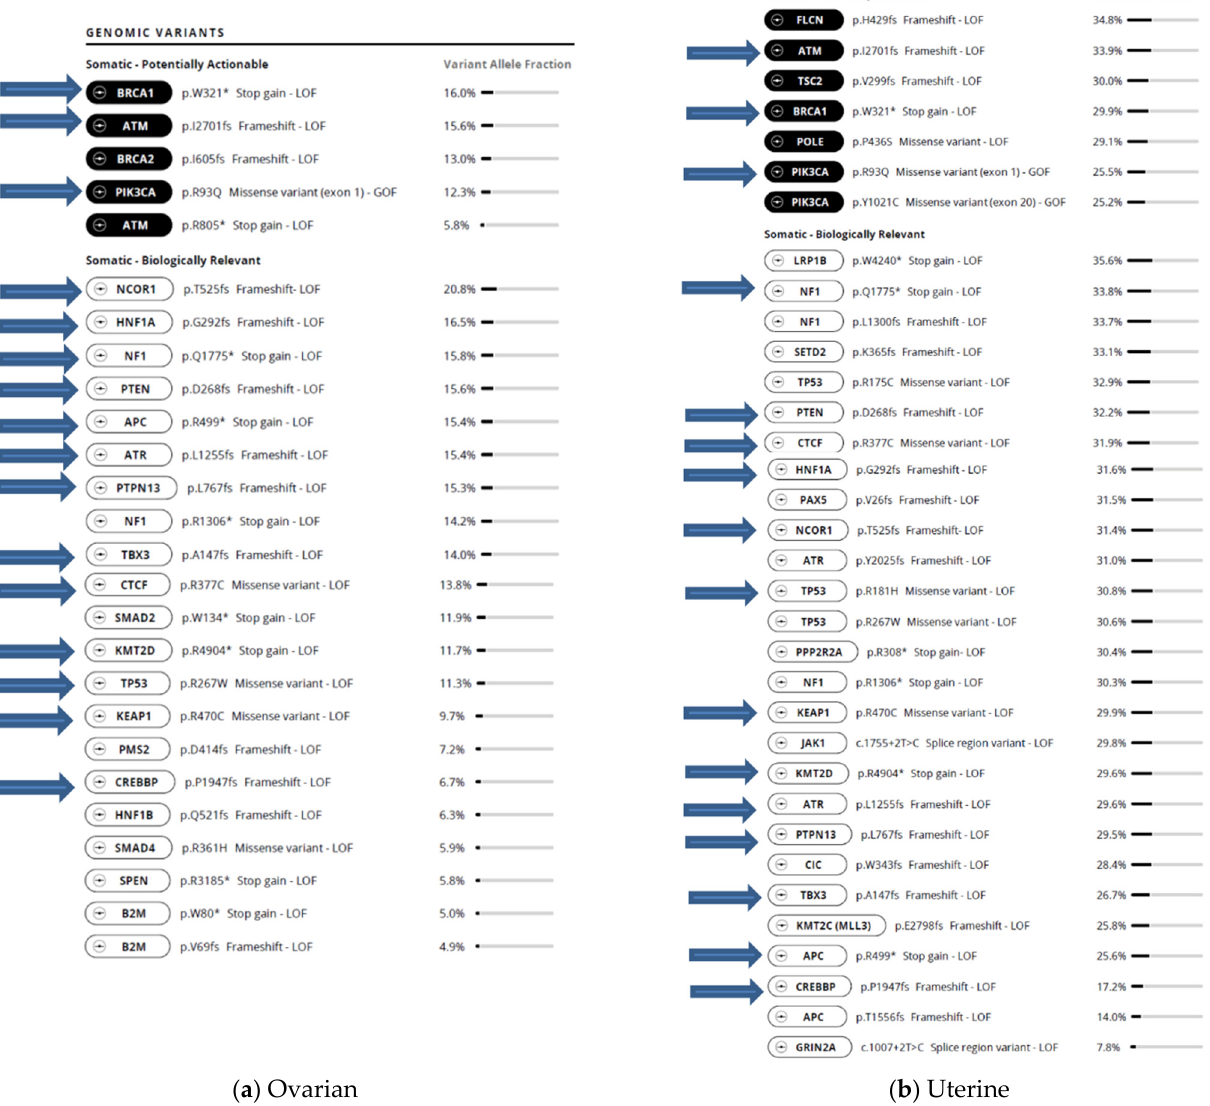
Figure 4. Somatic potentially actionable variants and biologically relevant variants (common variants shown with blue arrows) with variant allele fractions in ( a ) ovarian and ( b ) uterine tumors. A nonsense variant that removes the entire C-terminal part of the protein at the site of the variant is denoted with a * after the relevant amino